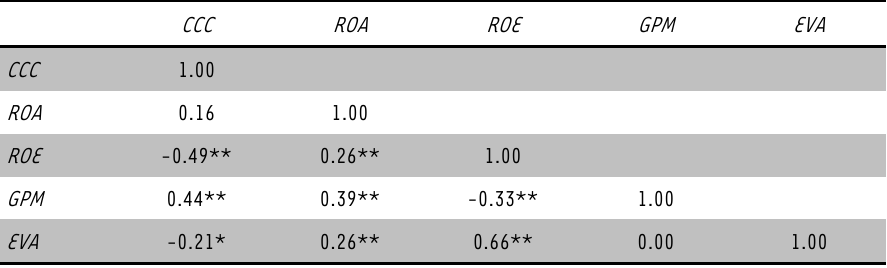
TABLE 2: Correlation between the CCC and the profitability measures CCC ROA ROE